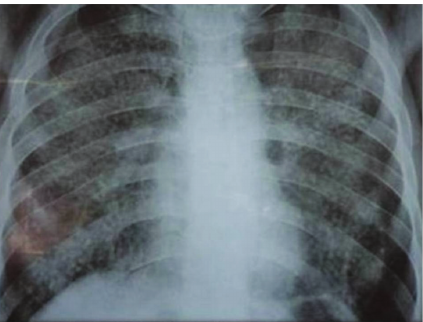
Figure 1: Chest X-ray: bilateral diffuse nodular opacities with bilateral pneumothorax.